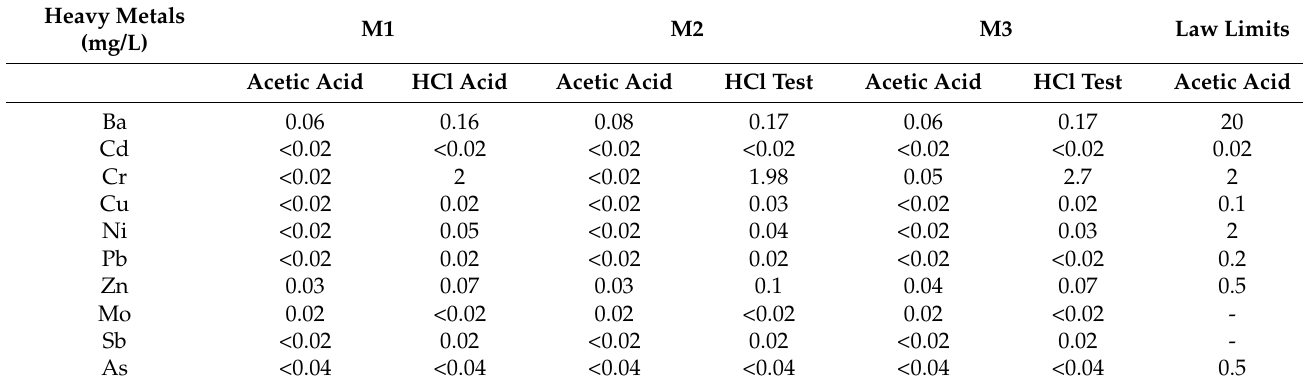
Table 6. Heavy metals (mg)L) in the AACs M1, M2, M3 eluates after the leaching test in acetic acid